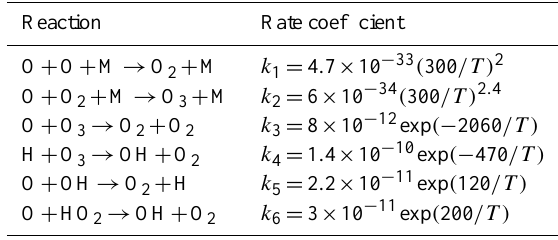
Table 1. Exothermic reactions and rate